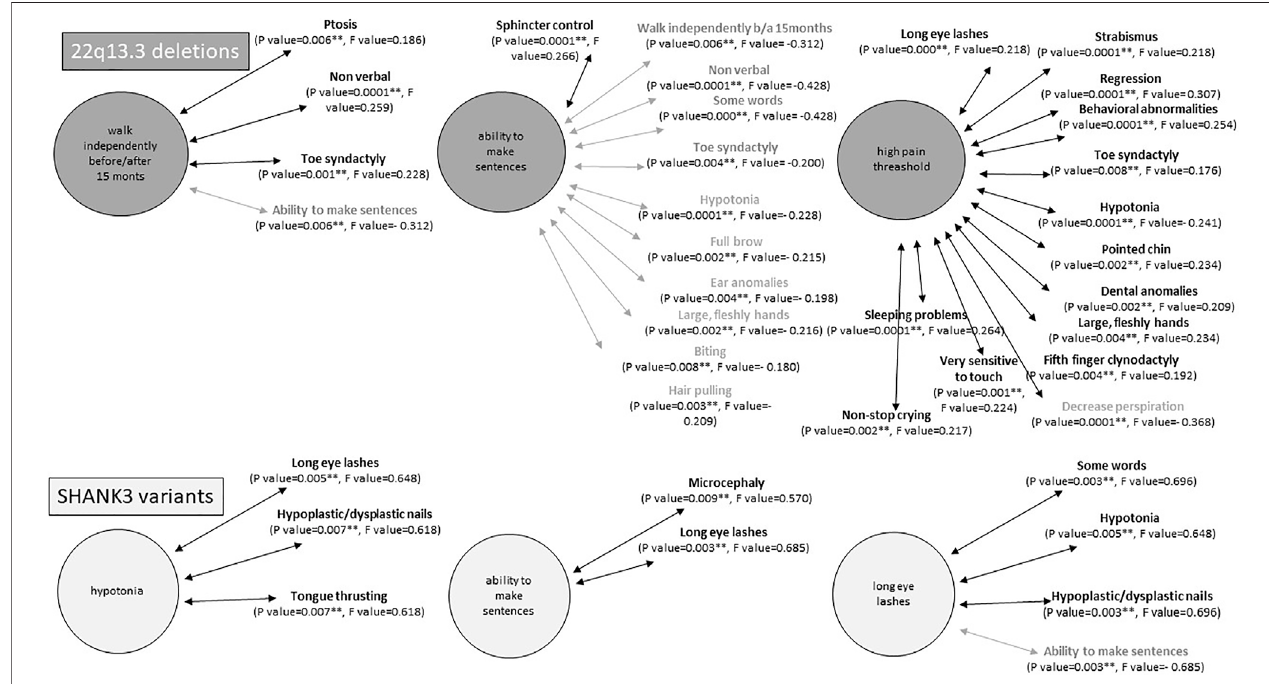
FIGURE 2 | Examples of statistically signi fi cant correlations ( p < 0.001) between intercategorical variables in individuals with 22q13.3 deletions (top) or SHANK3 variants (bottom). Statistical analyses were performed using Kendal tau_b correlation coef fi cient. In bold, positive correlations and in gray negative correlations.